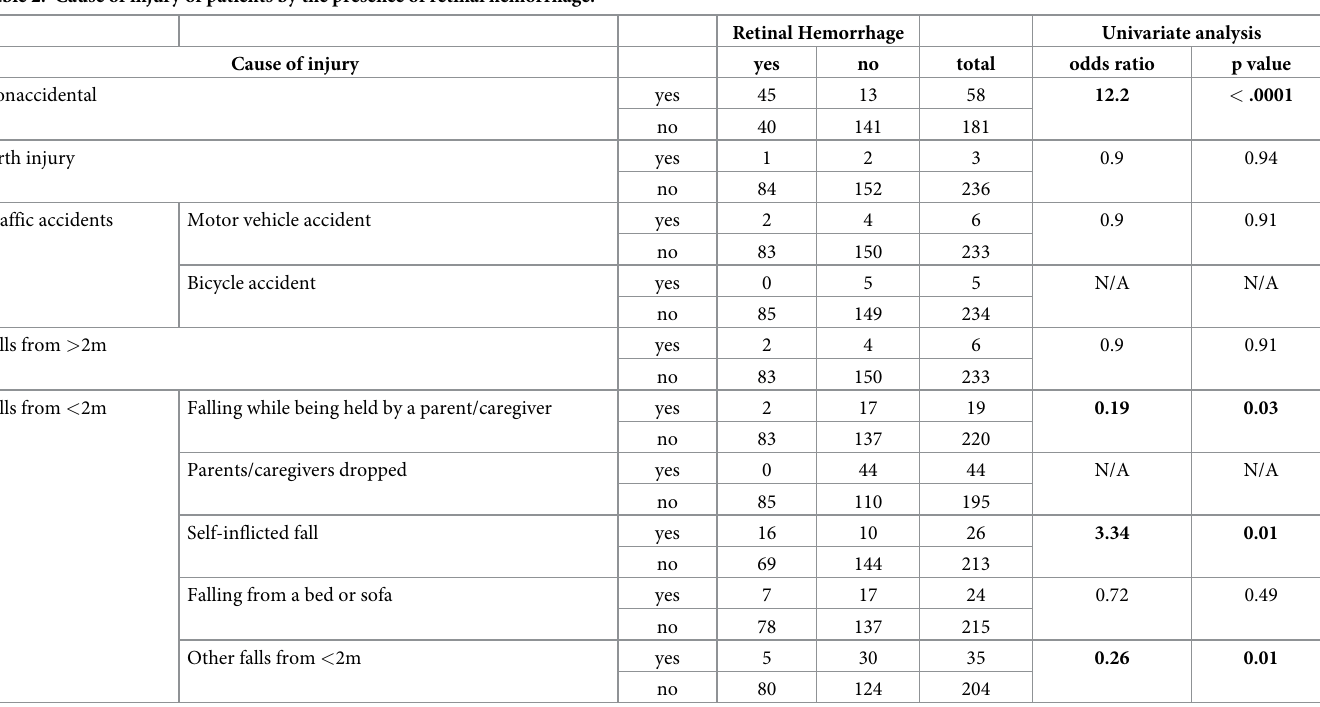
Table 2. Cause of injury of patients by the presence of retinal hemorrhage.